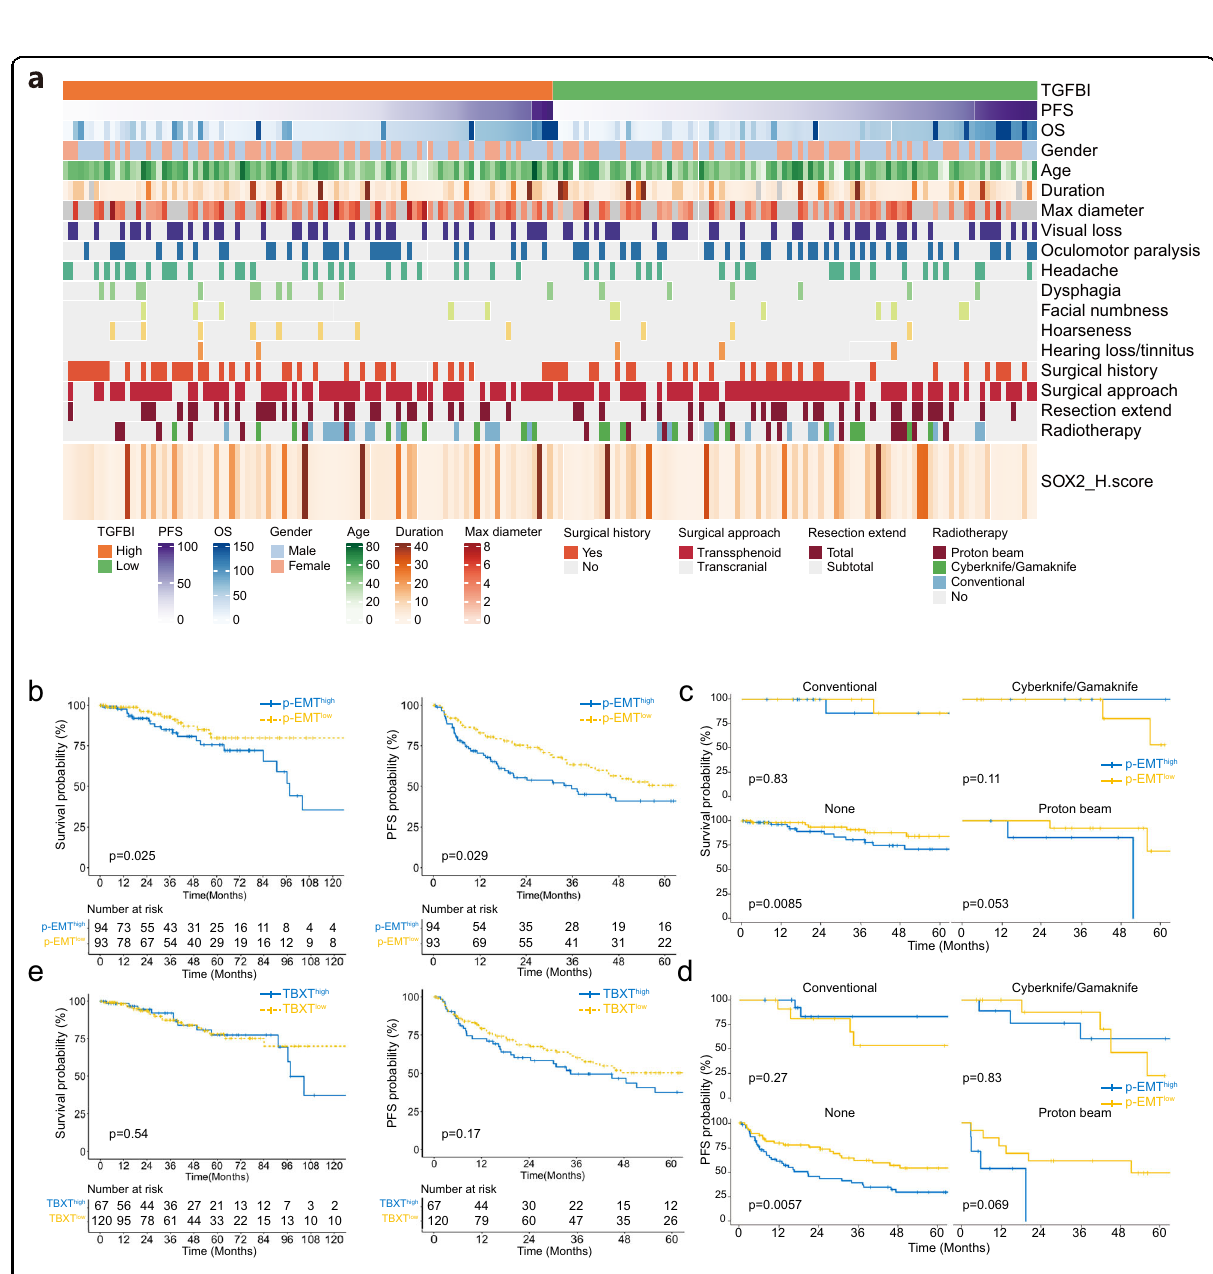
Fig. 6 Survival implications of p-EMT and TBXT in SBC. a The clinical data of the 187 SBC cohort were summarized. b Overall survival (OS) (left) and progression-free survival (PFS) (right) were signi fi cantly different between the p-EMT high and p-EMT low cohorts in 187 SBC patients. OS ( c ) and PFS ( d ) of patients with different postoperation radiotherapy. Patients with p-EMT high SBC and no postoperation radiotherapy had signi fi cantly lower OS and PFS. e OS (left) and PFS (right) showed no signi fi cant difference between the TBXT high and TBXT low cohorts in 187 SBC